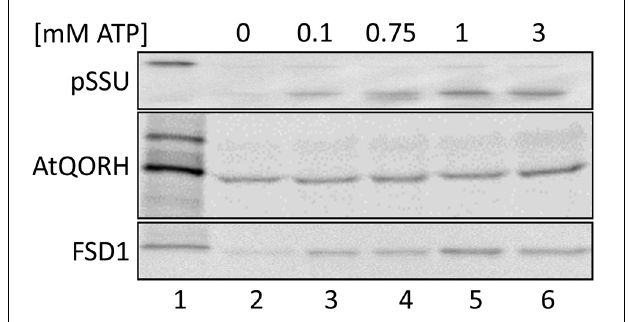
FIGURE 2 | Energy dependence of FSD1 import. In vitro import assays into pea chloroplasts are depicted. Lane 1 shows 10% of translation product. All samples were treated with thermolysin after import (lanes 2–6). ATP-concentrations in mM are indicated on top of the panel. Representative results from n = 3 independent experiments are